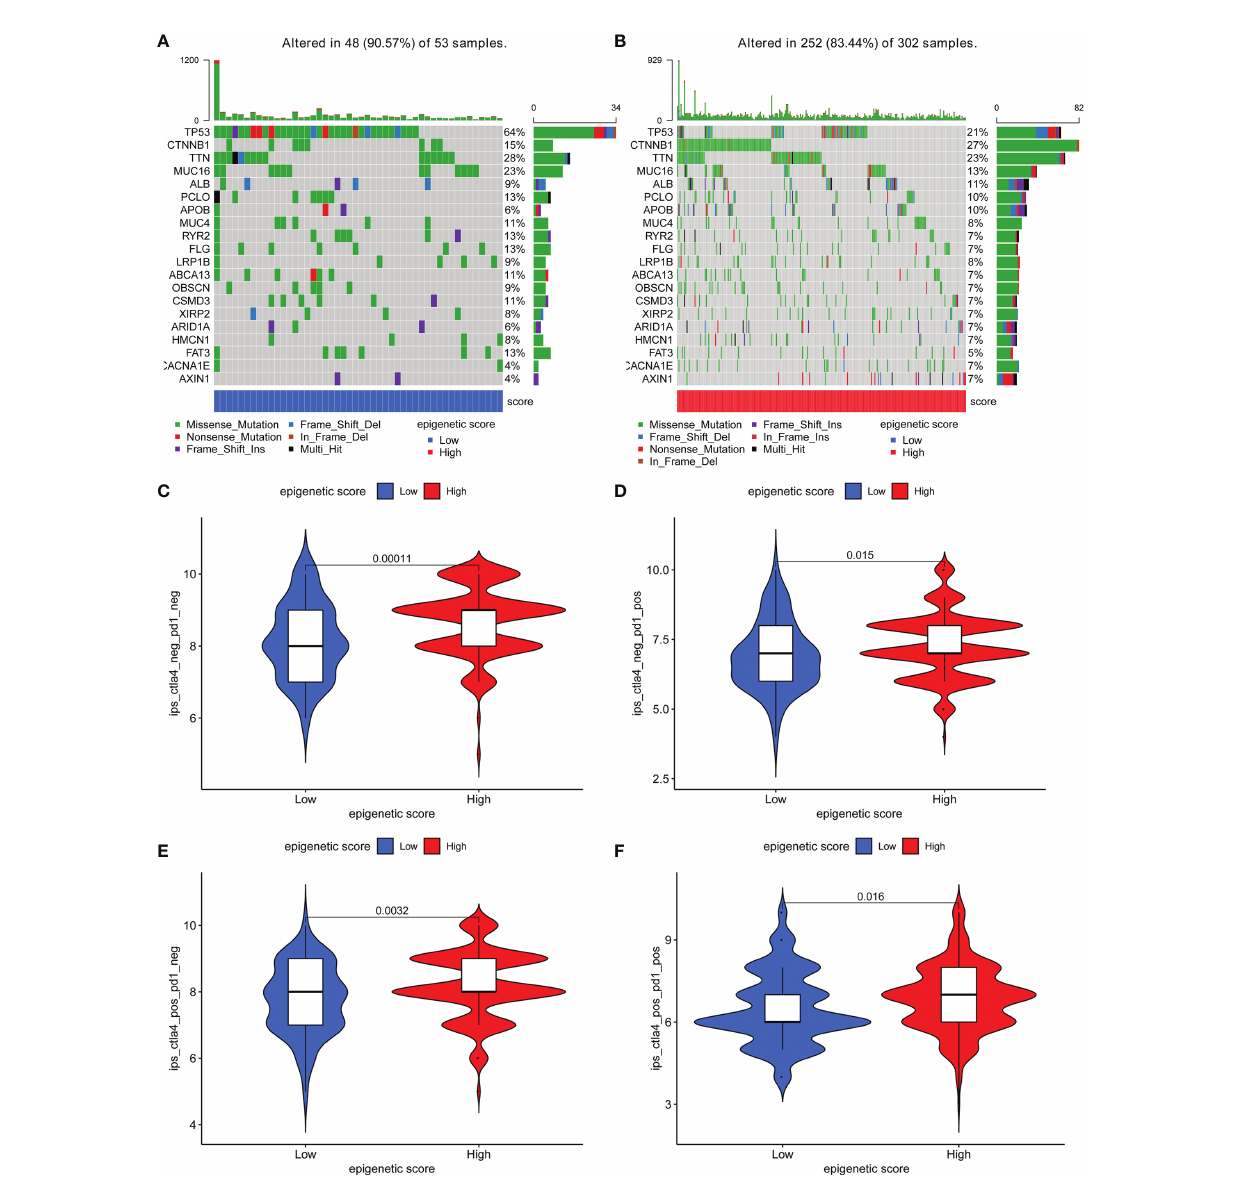
FIGURE 5 | Thedistributionofsomaticmutations amonglow andhighepigeneticscoregroupsandresponsiveness to CTLA-4 and PD-1 therapybasedonTheCancer ImmunomeAtlas(TCIA) database. (A) Thedistributionofsomaticmutationsamonglow epigeneticscoregroup; (B) Thedistributionofsomaticmutationsamong highepigenetic score group; (C) NegativePD-1 andNegativeCTLA-4; (D) PositivePD-1andNegativeCTLA-4; (E) NegativePD-1andPositive CTLA-4; (F) Positive PD-1andPositive